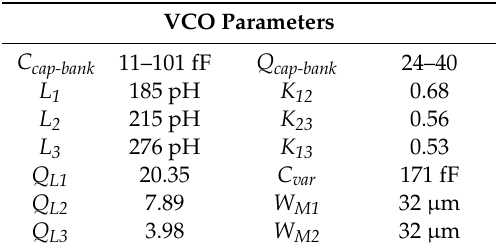
Table 1. This table shows the proposed VCO parameter values.